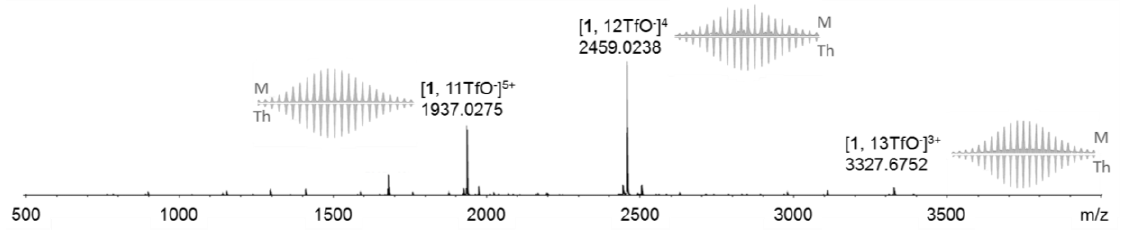
Figure 3. ESI-MS of self-assembly 1 in CH